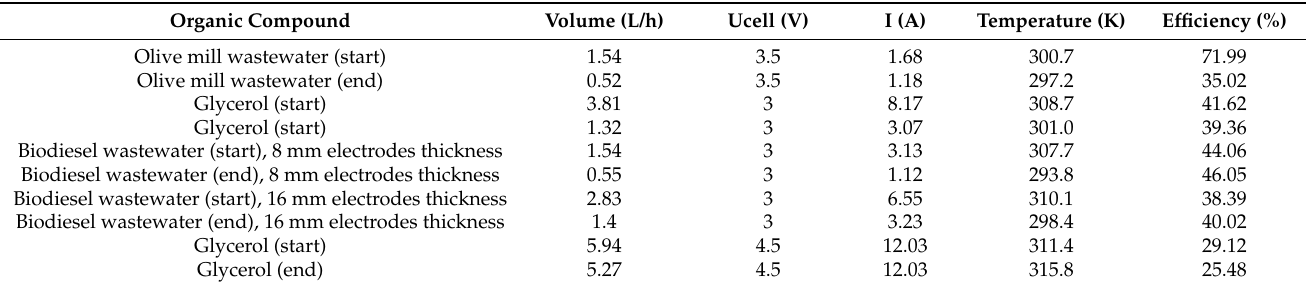
Table 3. Efficiency of the alkaline electro-oxidation process for different organic compounds: olive mill and biodiesel wastewaters, glycerol, and